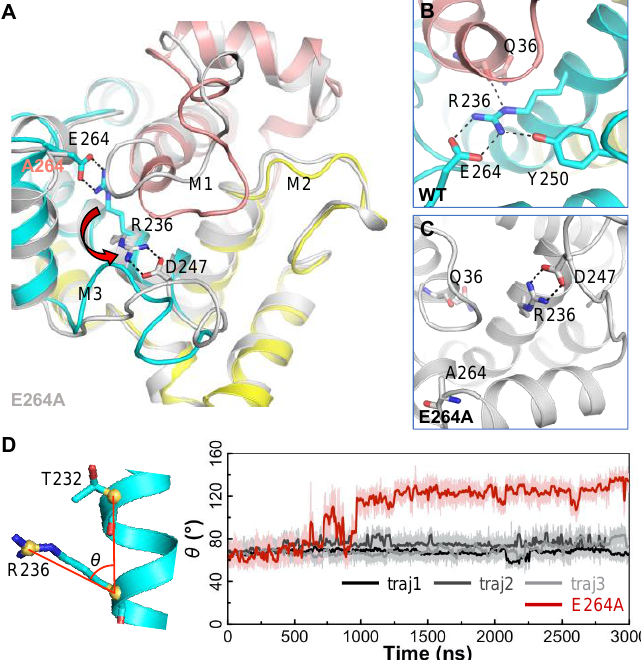
Figure 5. Impact of the E264A mutation on the structure of AAC. ( A ) Superimposed structures of the wild-type AAC (in color) and E264A-AAC mutant (in white) at the end of the 3 μ s simulations. The flip of the R236 side chain from wild-type conformation to the E264A mutant conformation is highlighted by a red arrow. ( B , C ) The detailed electrostatic interactions involving R236 in the wild-type AAC and E264A-AAC mutant. These interactions are shown by black dash lines. ( D ) Time evolutions of the side-chain orientation of R236 ( θ ) during the simulations of the wild-type AAC and E264A-AAC mutant. Here, θ is defined as the angle between the C ζ atom of R236, the Cα atom of R236 and the Cα atom of T232 (R236C ζ - R236Cα - T232 Cα). In ( A ) and ( B ), the structures of domains 1, 2 and 3 of wild-type AAC are shown in salmon, yellow and blue, respectively.